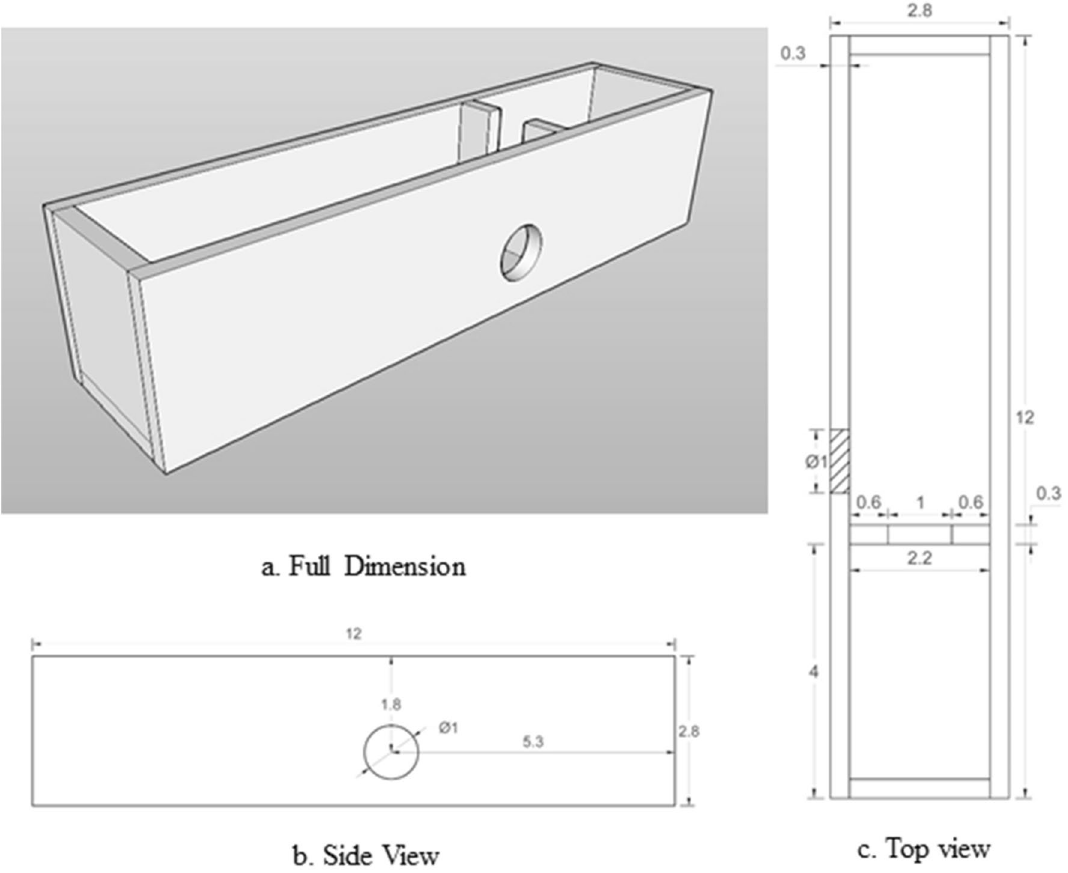
Figure 2. The shape of the mouse strainer in different views angle. There is a hole (1 × 1 cm) for the beam path. ( a ) Full dimension ( b ) Side view ( c ) Top view. (Scale in